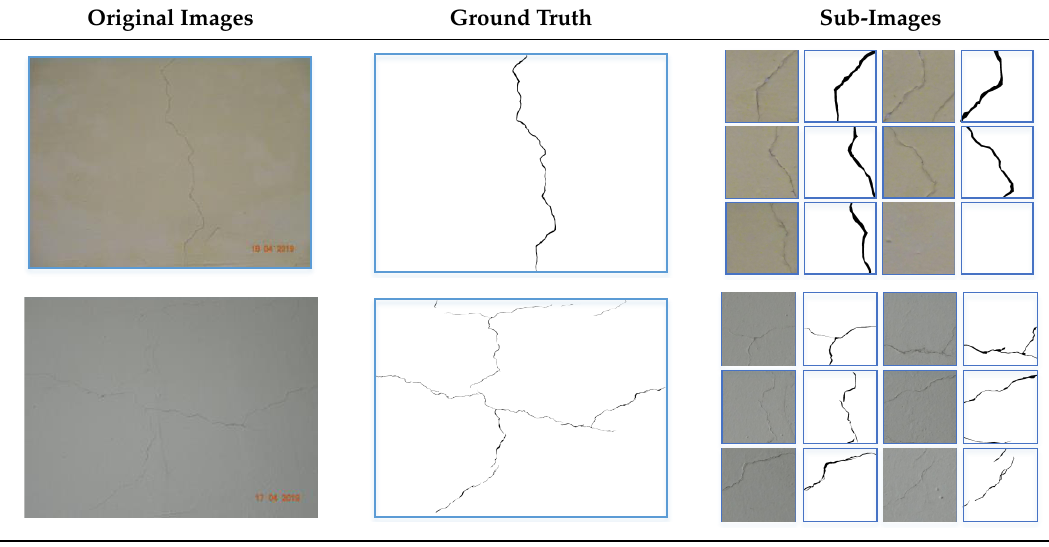
Table 2. The original image and ground truth image is divided into sub-images.